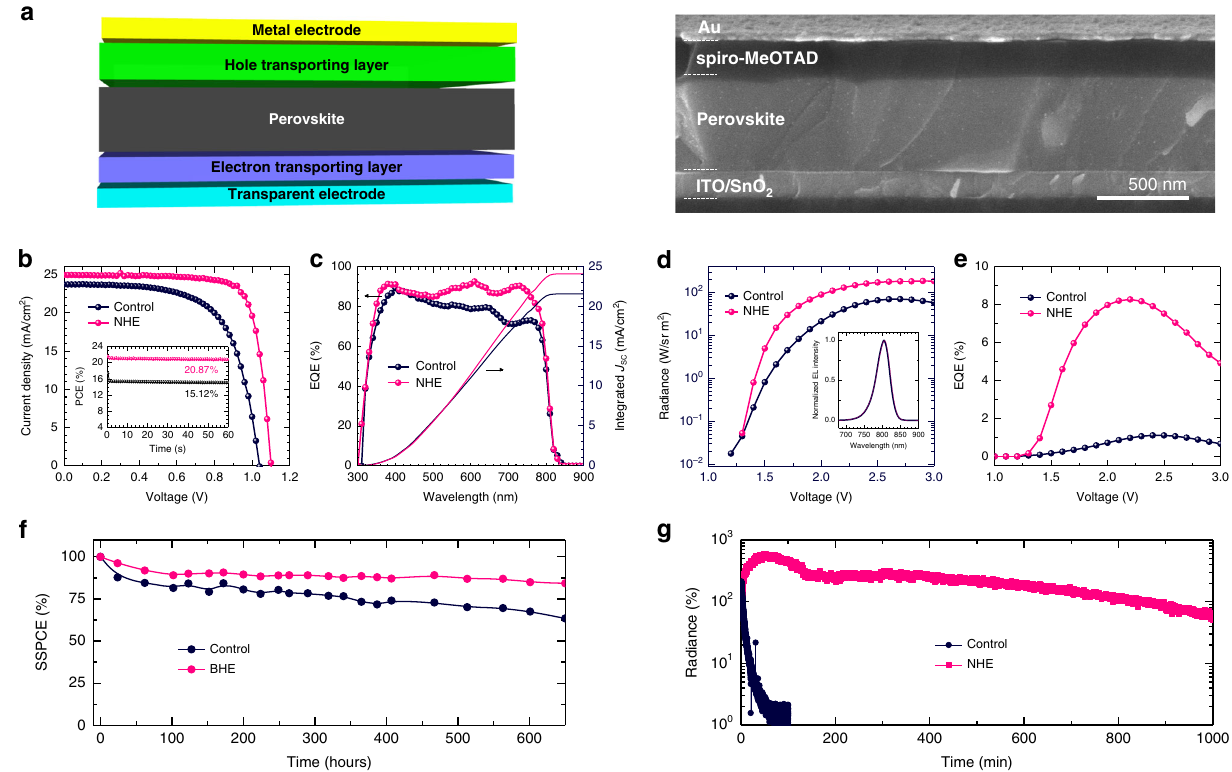
Fig. 4 Proof-of-concept devices. a Device structure schematics and corresponding cross-sectional scanning electron microscopy (SEM) image of the solar cell device based on the FAPbI 3 fi lm with nano heteroepitaxy (NHE, with 3.33 mol% FPEA 2 PbI 4 ). b Current density – voltage ( J – V ) and c external quantum ef fi ciency (EQE) curves of solar cell devices based on a bare FAPbI 3 fi lm (control) and a FAPbI 3 fi lm with NHE. Inset of b shows the steady-state power conversion ef fi ciencies (SSPCEs) measured at maximum power points. d Voltage – radiance curves of the light emitting diode (LED) devices, and e corresponding EQE curves of the LED devices based on the control and NHE fi lms. Inset of d shows the electroluminescence spectra of the LED devices. Operational stability measurements of the f solar cell (normalized SSPCE) and g LED devices (normalized radiance) based on the control and NHE fi